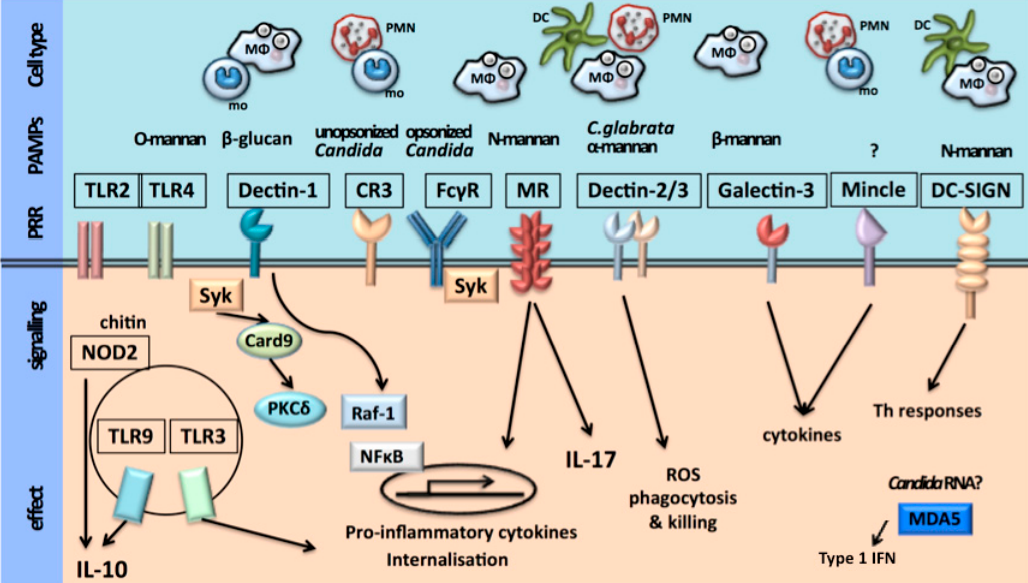
Figure 1. Recognition of Candida species by innate immune cells. Ligand binding to extracellular Toll-like receptors (TLRs), such as TLR2 and TLR4, leads to the production of pro-inflammatory cytokines during Candida infections. The intracellular TLRs that recognize nucleic acids—namely, TLR3 and TLR9—might also have a role in anti- Candida host responses. Chitin from C. albicans has been proposed to induce the production of interleukin-10 (IL-10) via a nucleotide-binding oligomerization domain-containing protein 2 (NOD2)-dependent mechanism and in this way may contribute to dampening pro-inflammatory host responses during fungal infection. The pattern recognition receptors (PRRs) dectin 1, dectin 2 and dectin 3, and Fc receptors for IgG (Fc γ Rs), induce responses in a spleen tyrosine kinase (SYK)-dependent manner, whereas the signalling pathways engaged by the mannose receptor remain unknown. Dectin 1 can interact with TLR2 and can induce intracellular signalling via SYK- and RAF proto-oncogene serine/threonine-protein kinase (RAF1)-dependent pathways. Complement receptor 3 (CR3) is important for the recognition of unopsonized Candida , whereas Fc γ Rs are important for recognition of opsonized Candida by neutrophils. Dendritic cell (DC)-specific -ICAM3-grabbing non-integrin (DC-SIGN) recognizes N-linked mannans of Candida and has a role in inducing T helper (TH) cell responses. There is no known Candida -derived ligand that triggers the macrophage-inducible C-type lectin receptor (MINCLE), whereas β -mannans from Candida are recognized by galectin 3. Although a role for melanoma differentiation-associated protein 5 (MDA5) in anti- Candida host responses has been described, it remains to be determined what ligand induces MDA5 activation. Together, these signalling pathways induce the secretion of cytokines and chemokines and initiate phagocytosis to clear Candida infections. CARD9, caspase activation and recruitment domain-containing 9; C. glabrata , Candida glabrata ; NF- κ B, nuclear factor- κ B; PAMP, pathogen-associated molecular pattern;